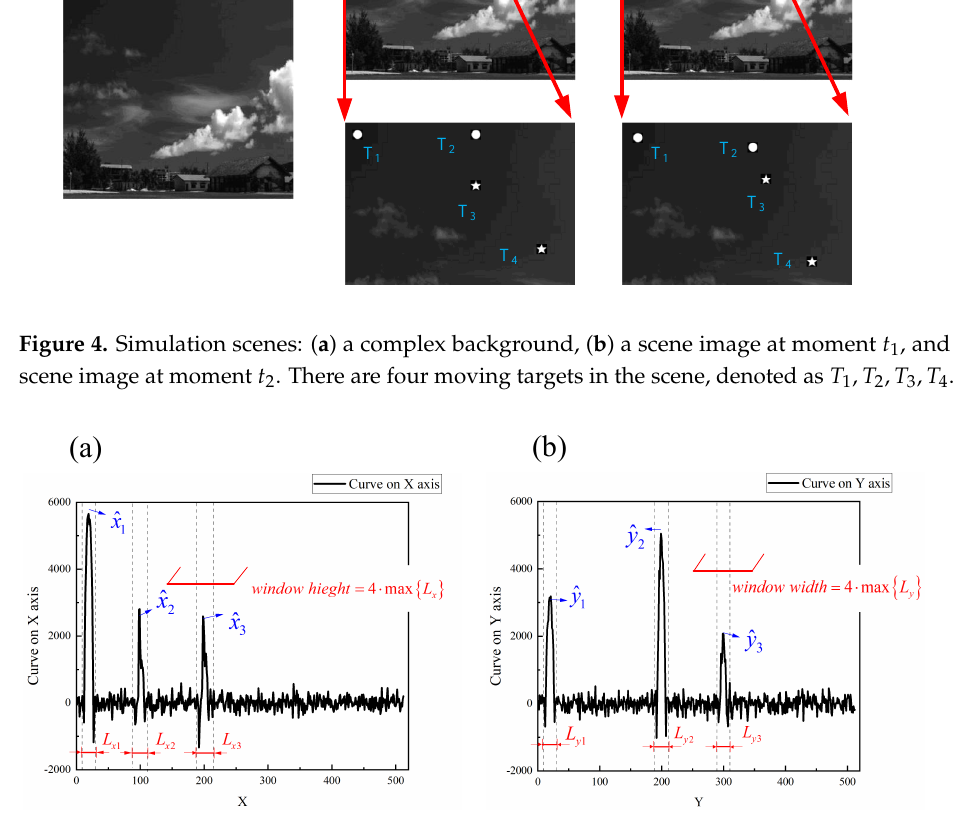
Figure 5. Projected curves of the image with four targets. ( a ) is the projected curve of image scene on X axis and ( b ) is the projected curve on Y axis. ( ˆ x 1 , ˆ x 2 , ˆ x 3 ) are the three regions on the X axis where the target may exist, and ( ˆ y 1 , ˆ y 2 , ˆ y 3 ) are the three regions on the Y axis. The length L x and L y of the regions determine the size of window